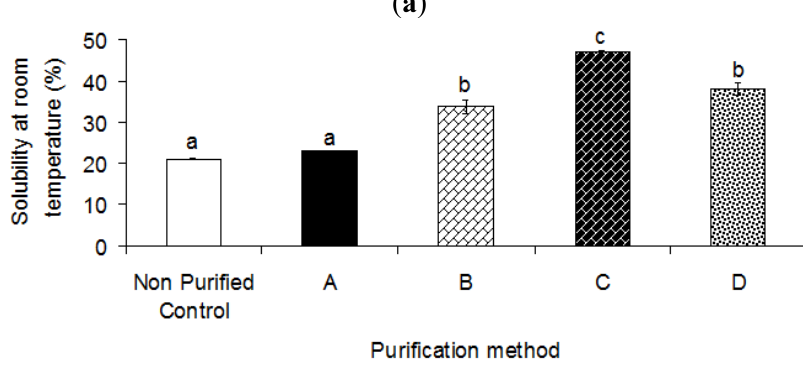
Figure 3. Effect of different purification methods on the solubility of hetero- polysaccharide-protein biopolymer from durian seed at ( a ) room temperature; ( b ) elevated temperature (80 °C). A, Isopropanol and ethanol; B, Isopropanol and acetone; C, Saturated barium hydroxide; D, Fehling